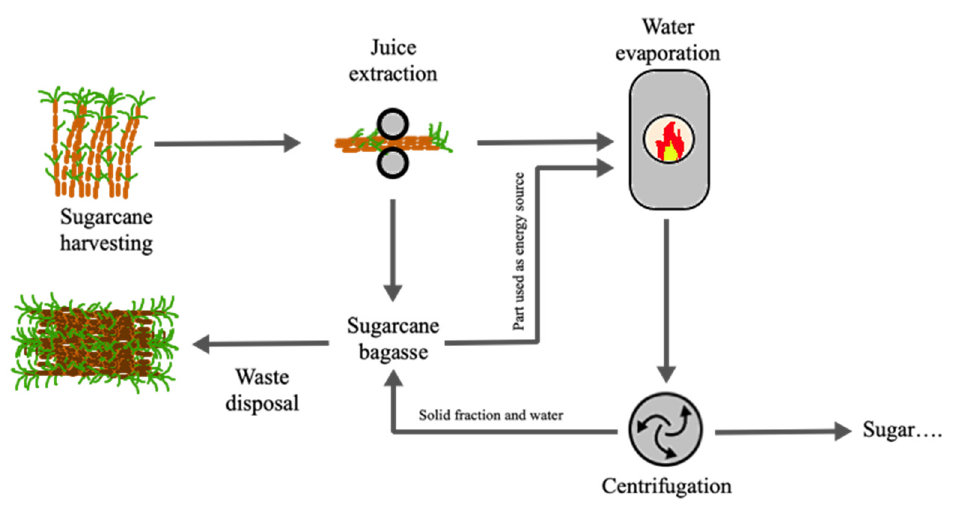
Figure 1. Simplified sugar production process (adapted from [59]).